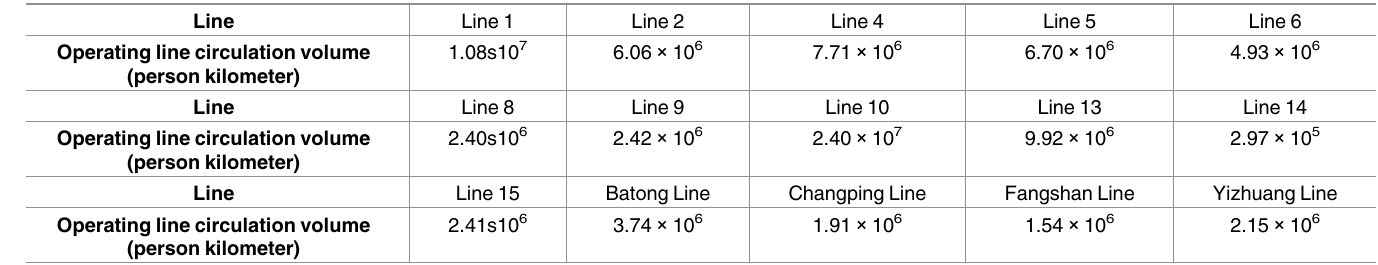
Table 3. Operating line circulation volumes of all lines in Beijing Metro network. Line